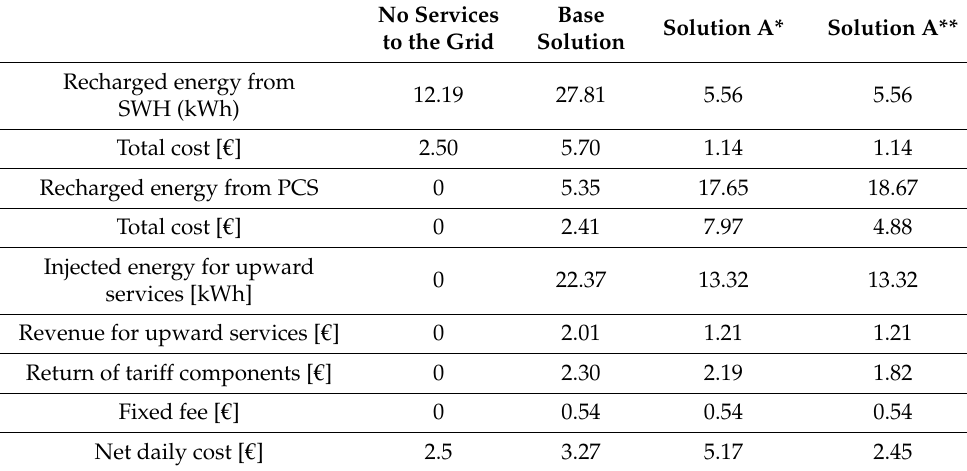
Table 22. Results for mobility pattern1—UVAM (Scenario B).